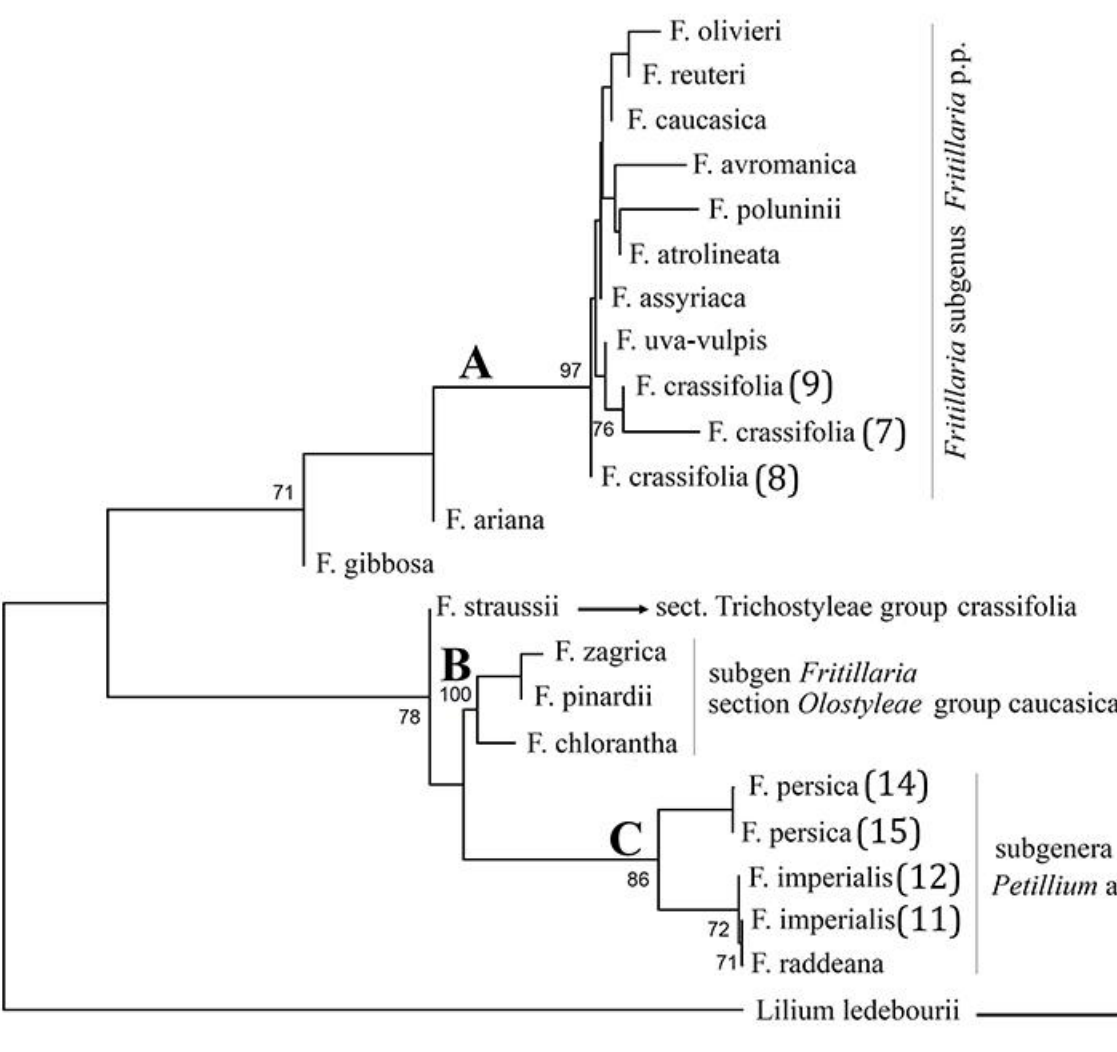
Fig. 1. Minimum Evolution (ME) tree of Fritillaria species with Lilium ledebourii as outgroup. Tree was inferred from analysis of trnH-psbA sequences. Bootstrap values >70 from 1000 replicates are shown at the